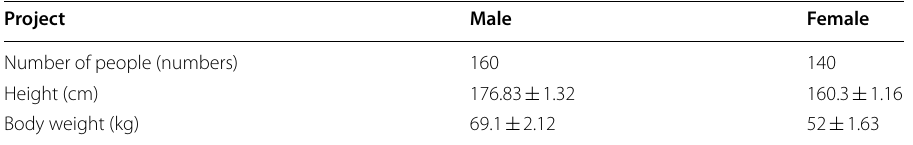
Table 1 Statistics of experimental test objects